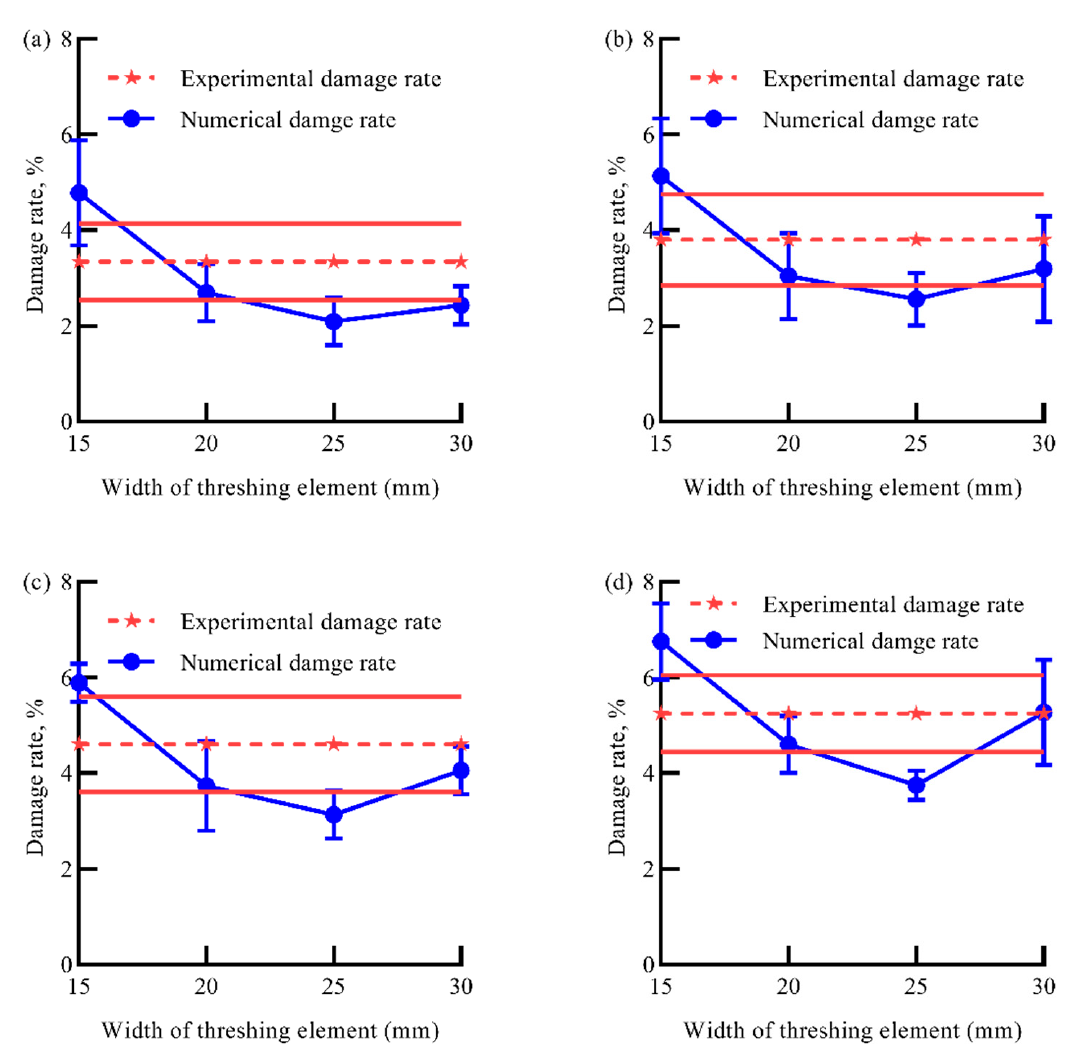
Figure 6. Effects of the width of threshing component on the simulation results of threshing rate at the drum rotation rate of ( a ) 122.70 rpm, ( b ) 187.15 rpm, ( c ) 252.10 rpm and ( d ) 317.15 rpm.